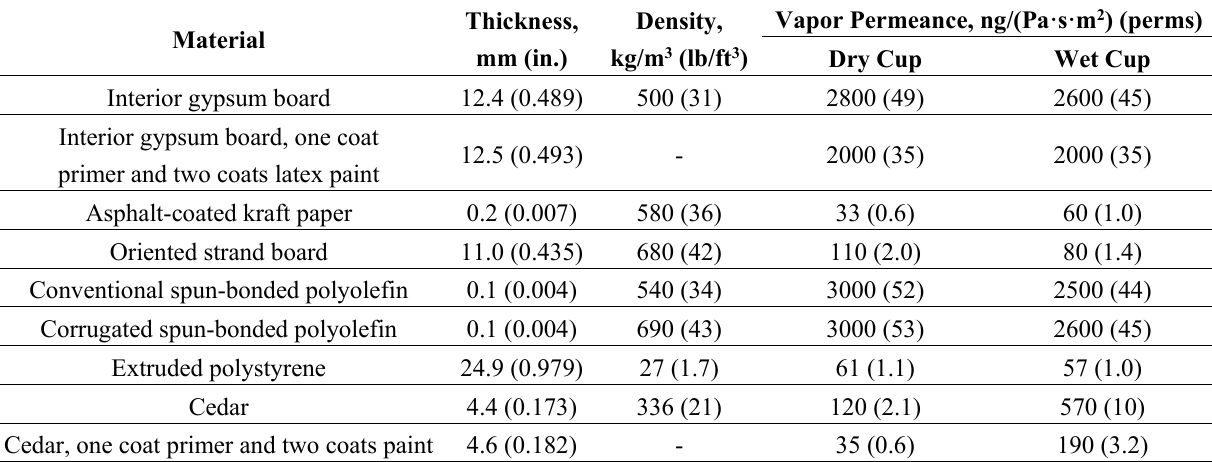
Table 2. Measured material